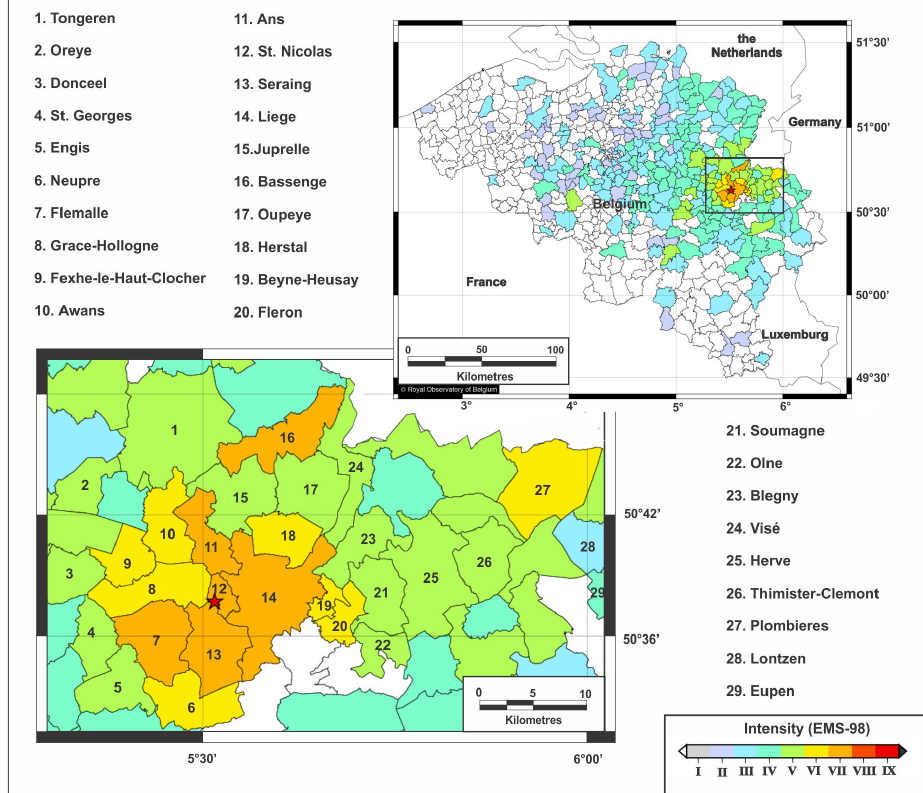
Fig. 1. Macroseismic map of the 1983 Li`ege earthquake (http://seismologie.oma.be). The black rectangle indicates the region of interest in the present study, which coincides with the most damaged localities. The numbers indicate the names of the different localities of this region. Red star: earthquake epicentre.